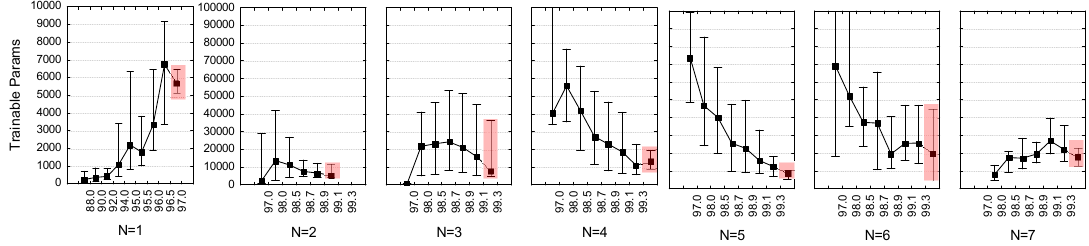
Figure 7. Number of trainable parameters in function of the validation BAC performance. The distributions are presented as median values (dots) and quartile ranges (whiskers). The number of parameters of the top-ranked performance models is highlighted in the rightmost distributions.